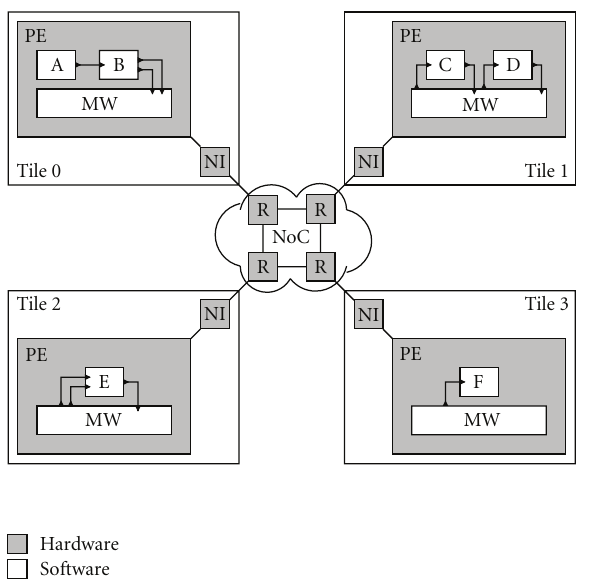
Figure 2: KPN example mapped on 2 × 2 mesh NoC platform.